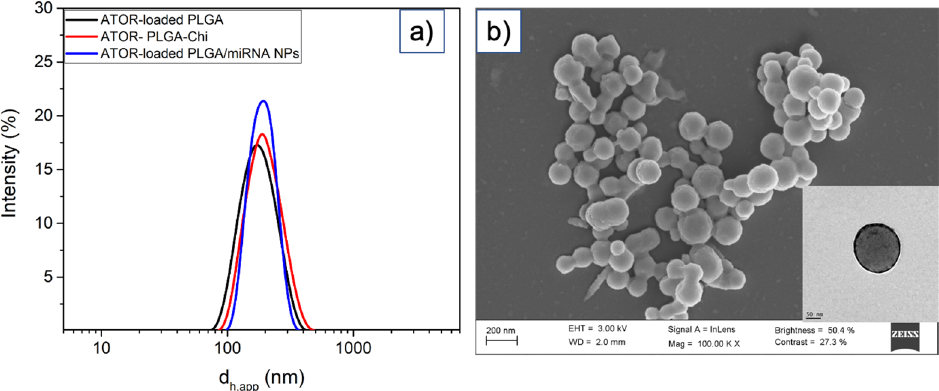
Figure 1. Hydrodynamic size populations (apparent hydrodynamic diameter, d h,app , of ( a ) ATOR- loaded PLGA (black line); ATOR-loaded PLGA stabilized with chitosan (red line), and ATOR-loaded PLGA/miRNA NPs (blue line). ( b ) SEM image of ATOR-loaded PLGA/miRNA NPs. The inset in ( b ) denotes a TEM image of the same NPs.